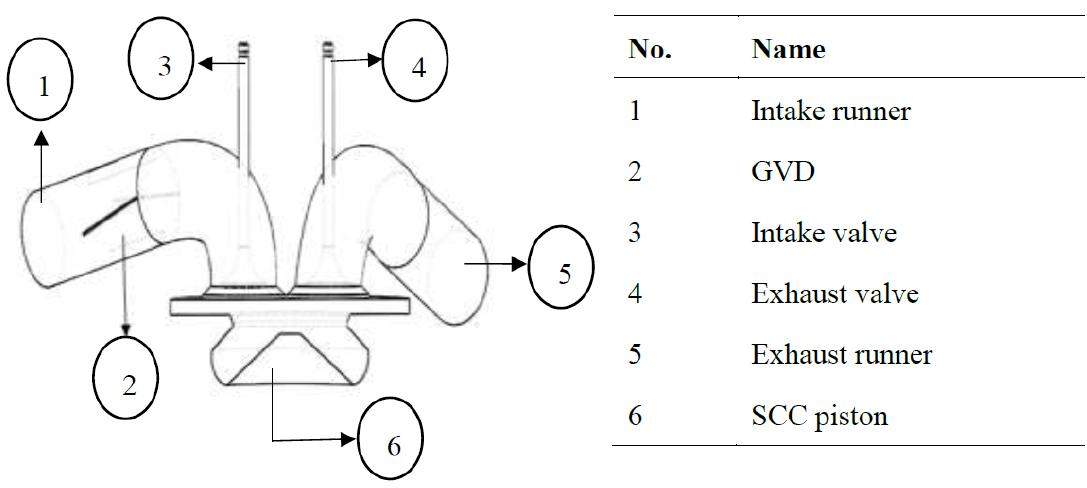
Figure 3. YANMAR L70AE CI generator diesel engine SolidWorks model.